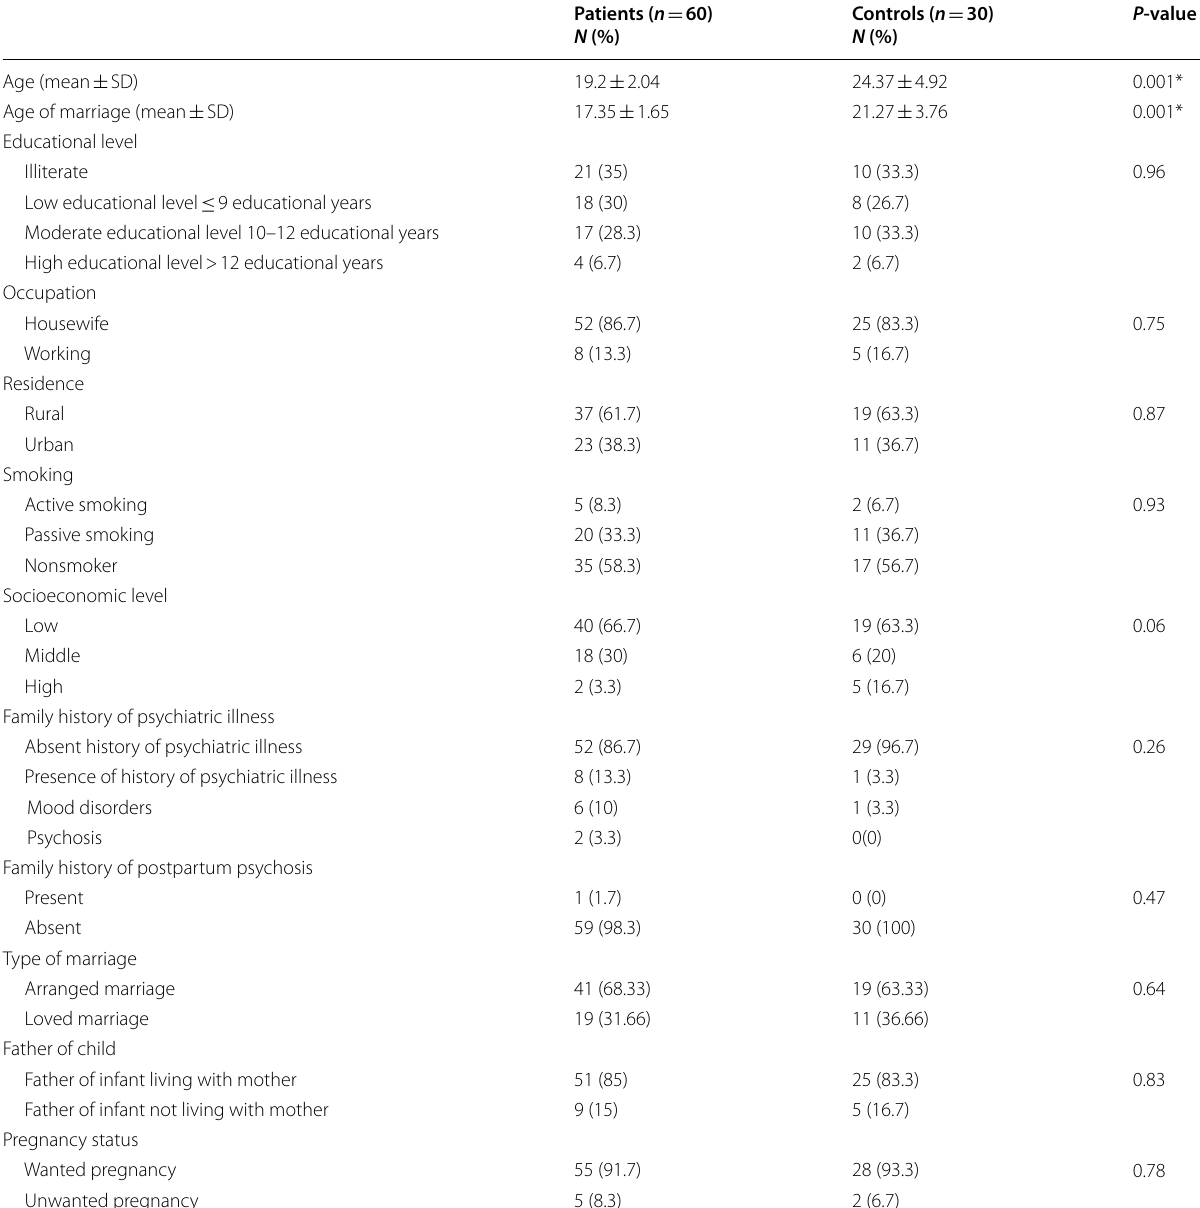
Table 1 Sociodemographic among studied